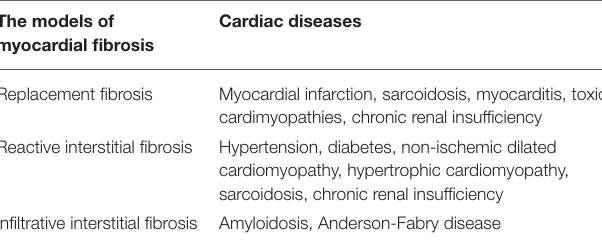
TABLE 1 | Cardiac diseases that cause myocardial